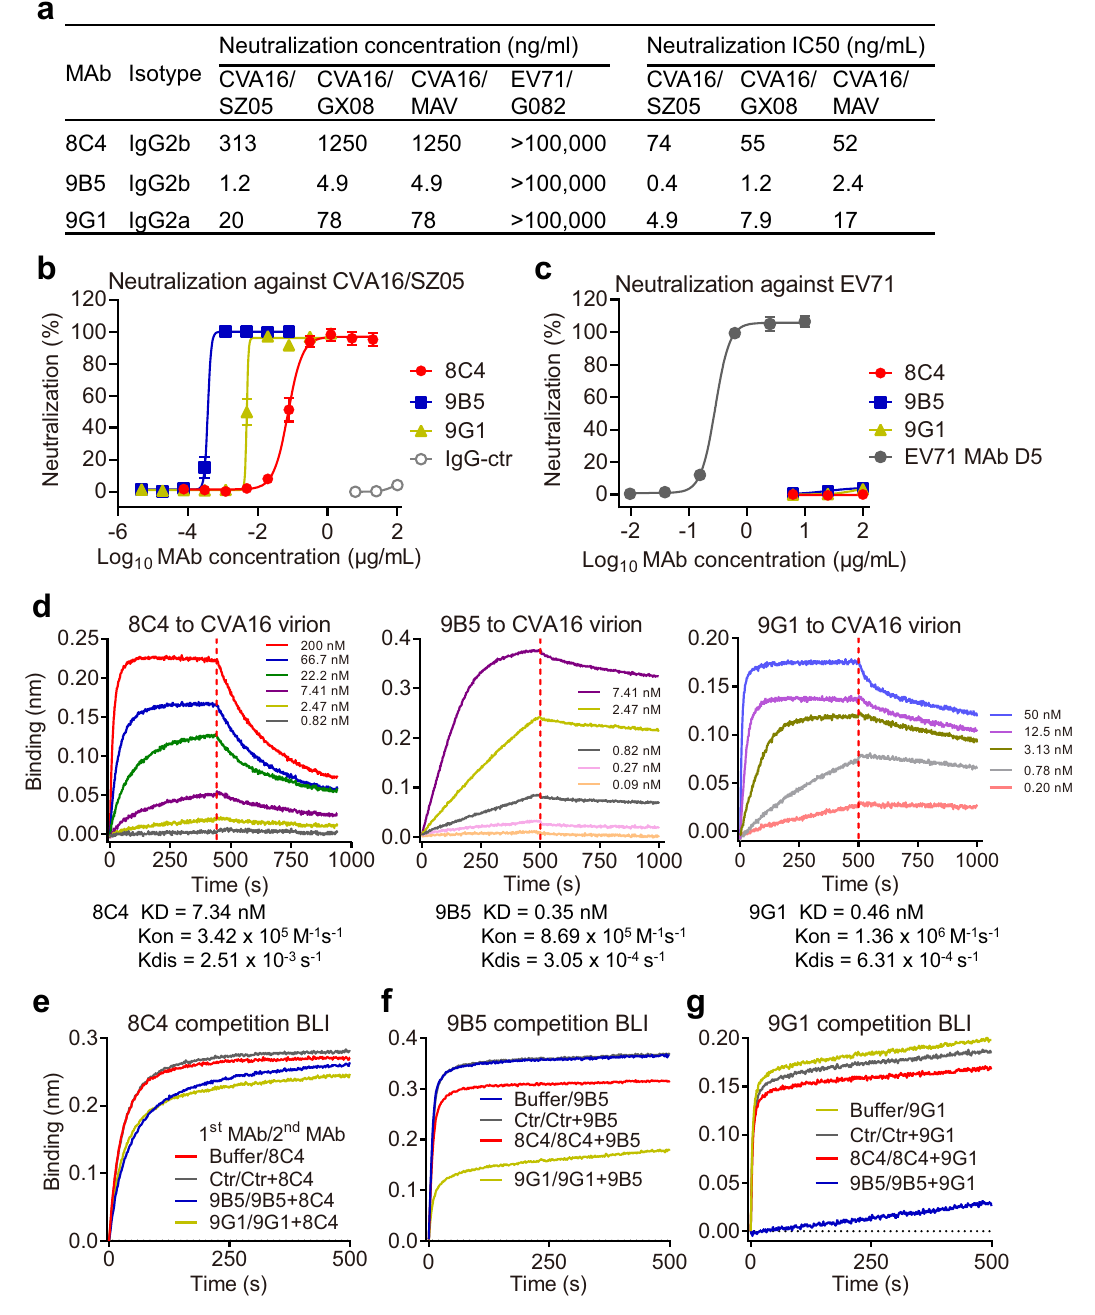
Fig. 1 | Neutralization, binding af fi nity and mutual competition of anti-CVA16 MAbs. a Isotypes and neutralization of anti-CVA16 MAbs (8C4, 9B5, and 9G1). Neutralization concentration was de fi ned as the lowest antibody concentration that fully prevented cytopathic effect. Neutralization IC50 of each MAb against CVA16 was determined by the cell viability assay. b Neutralization of the MAbs againstCVA16strainSZ05wasmeasuredbythecellviabilityassay.Anti-SARS-CoV-2 MAb2H2served as negative control(IgG-ctr). c Neutralizationofthe MAbs against EV71. Anti-EV71 MAb D5 served as positive control in this assay. In b , c , data are mean±SEMof fi vereplicatewellsin96-wellcellcultureplates. d Bindingkineticsof